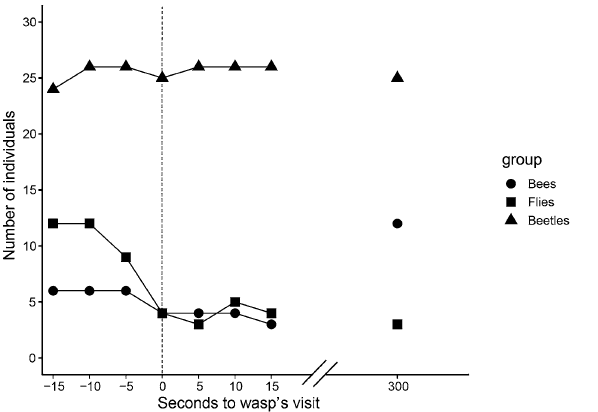
Figure 5. Time course of change in the number of flower-visiting insects by taxonomic group before and after the arrival of wasps. Dashed line shows the time of wasps’ arrival to the flower. Data for all flowers examined were